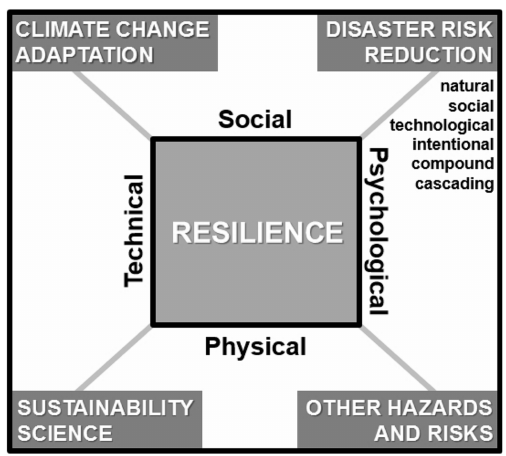
Fig. 7. Summary of the position of resilience studies in the